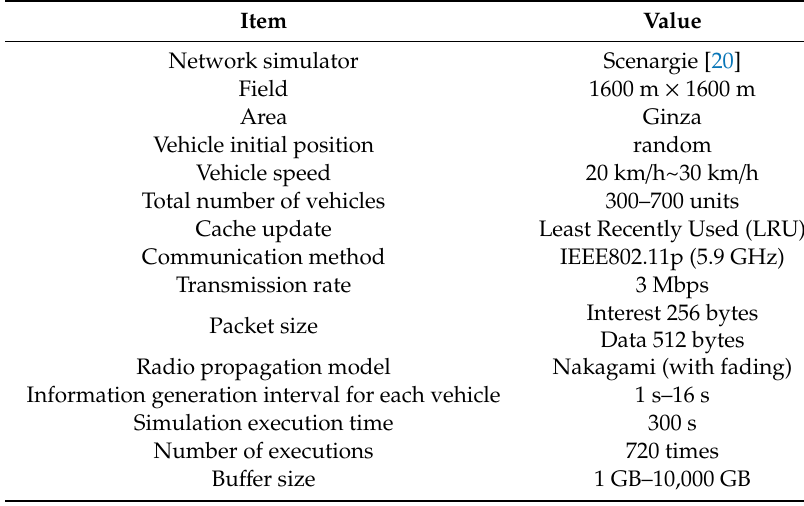
Table 4. Simulation